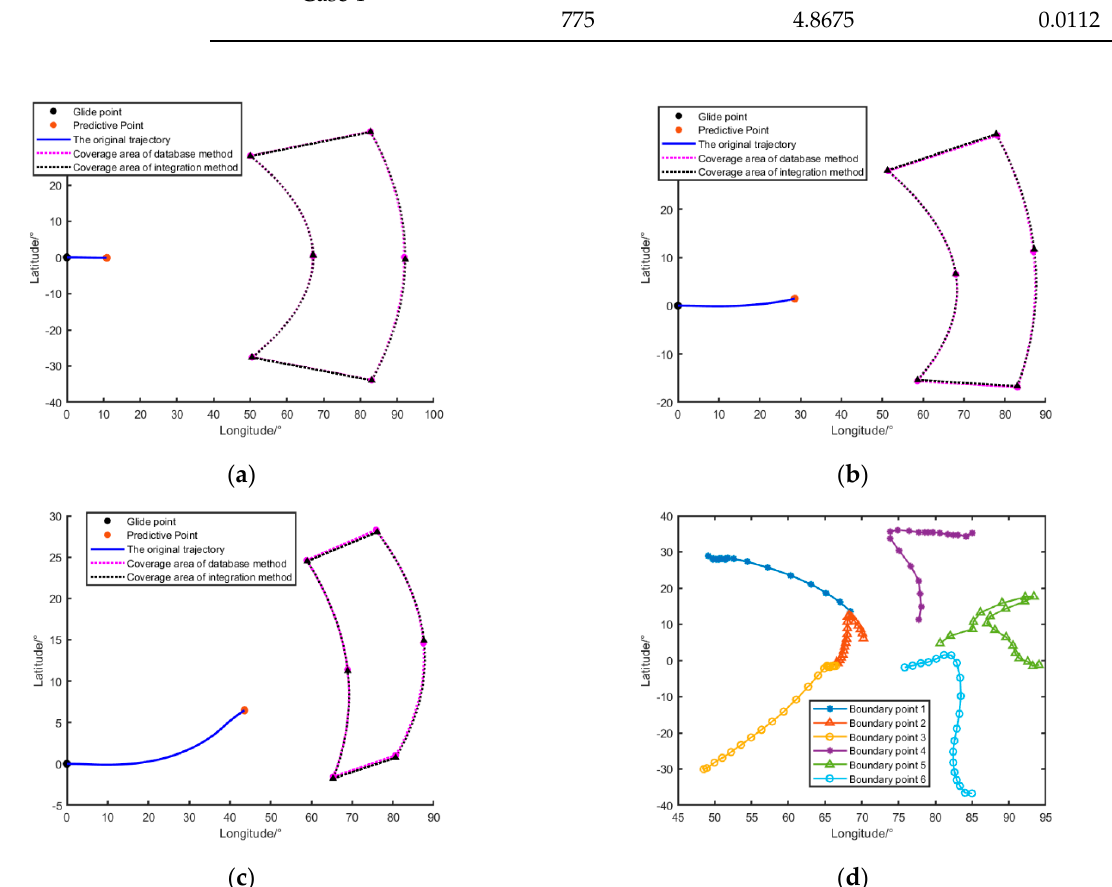
Figure 8. The result of case 1: ( a ) is t p = 175 s; ( b ) is t p = 475 s; ( c ) is t p = 775 s; ( d ) is the boundary point trajectory. Table 5. The relative errors of the six boundary points.